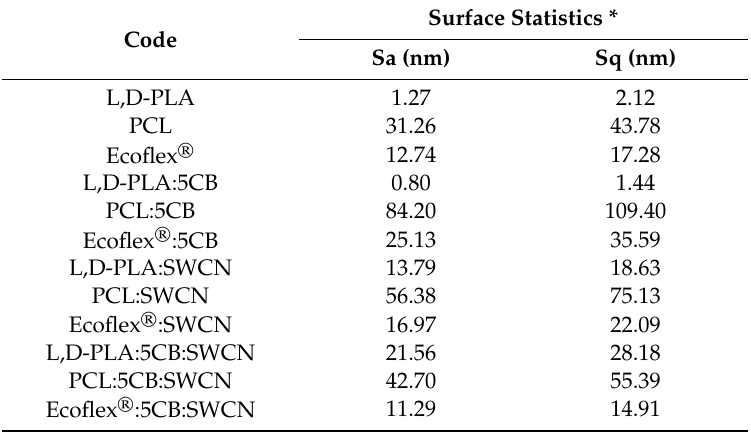
Table 2. The surface parameters of the polymers and hybrid compositions.